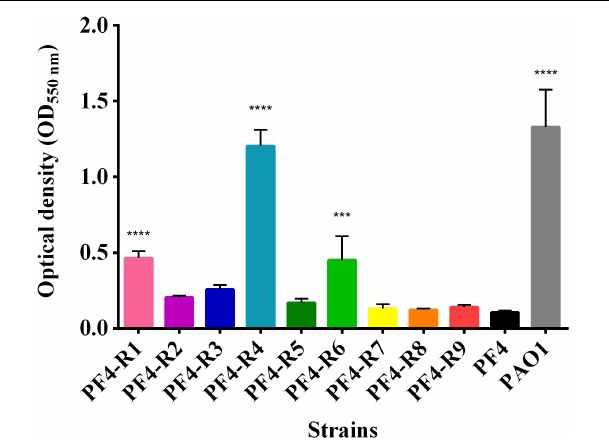
FIGURE 5 | Biofilm formation of V. anguillarum strains resistant to the CHOED phage. The analyses of each strain carried out in quadruplicate in 96-well plates staining the exopolysaccharide in the biofilms with 0.1% crystal violet as described in materials and methods. Error bars represent standard deviation. ( ∗∗∗ ) Significantly different from parental PF4 strain ( p < 0.001); ( ∗∗∗∗ ) significantly different from the parental strain PF4 ( p < 0.0001).